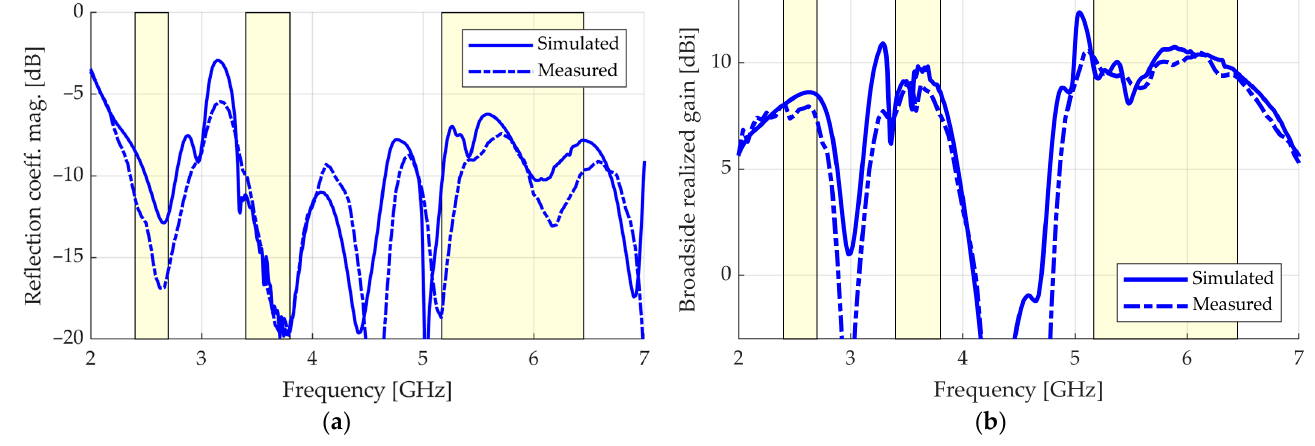
Figure 16. Results: ( a ) reflection coefficient magnitude; ( b ) broadside realized gain.